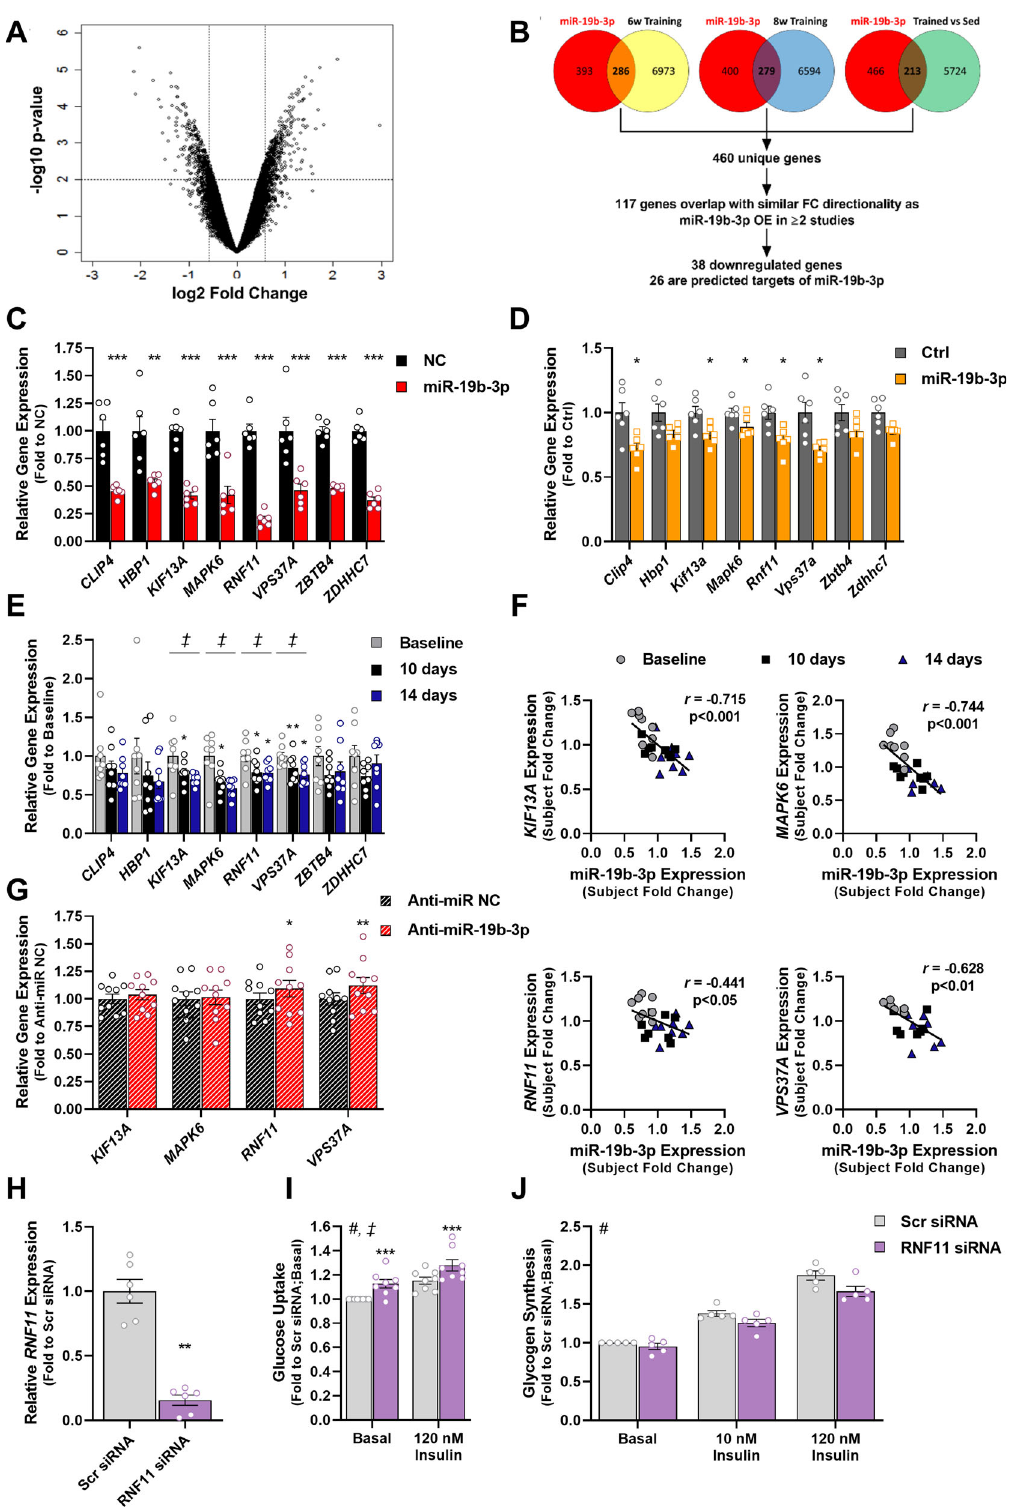
has a profound effect on metabolism 13 , we deprioritized further studies on miR-107. Consequently, we selected the exercise- regulated miR-19b-3p for further validation to gain insight into mechanisms by which aerobic exercise training alters insulin sensitivity and metabolism in skeletal muscle. The molecular networks contributing to the adaptation to exercise in human skeletal muscle are not fully identi fi ed.